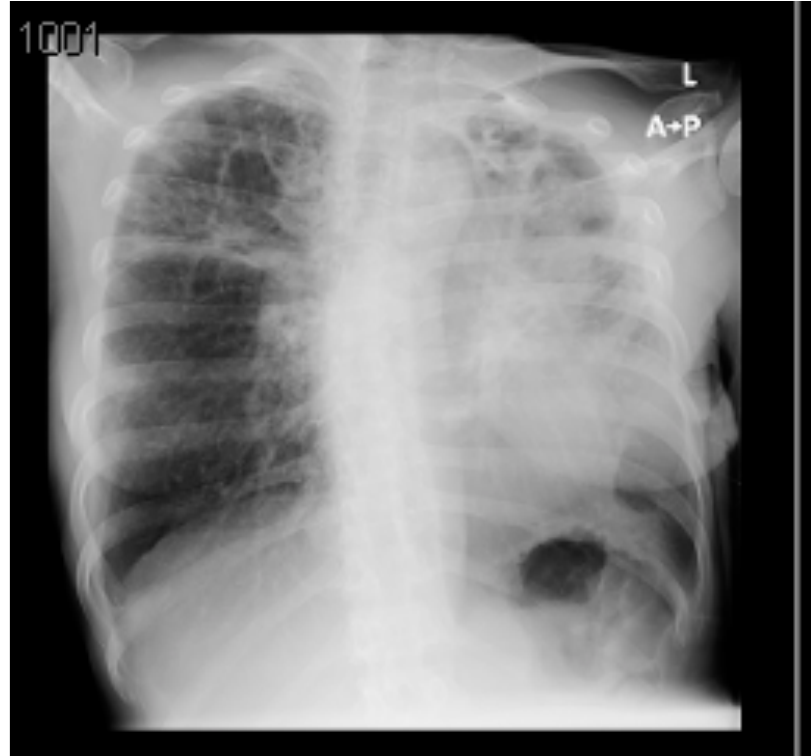
Figure 4. Posteroanterior chest X-ray (CXR) of the fourth case. The CXR shows diffuse reticular opacities are seen in both lungs with almost complete opacification of the left lung, which also shows faint cystic changes. Mild pneumothorax cannot be excluded with these cystic and emphysematous changes. The overall findings are suggestive of chronic interstitial lung disease (associated with cystic pattern), superimposed by consolidation in keeping with infection. Small bilateral pleural effusion is also seen.